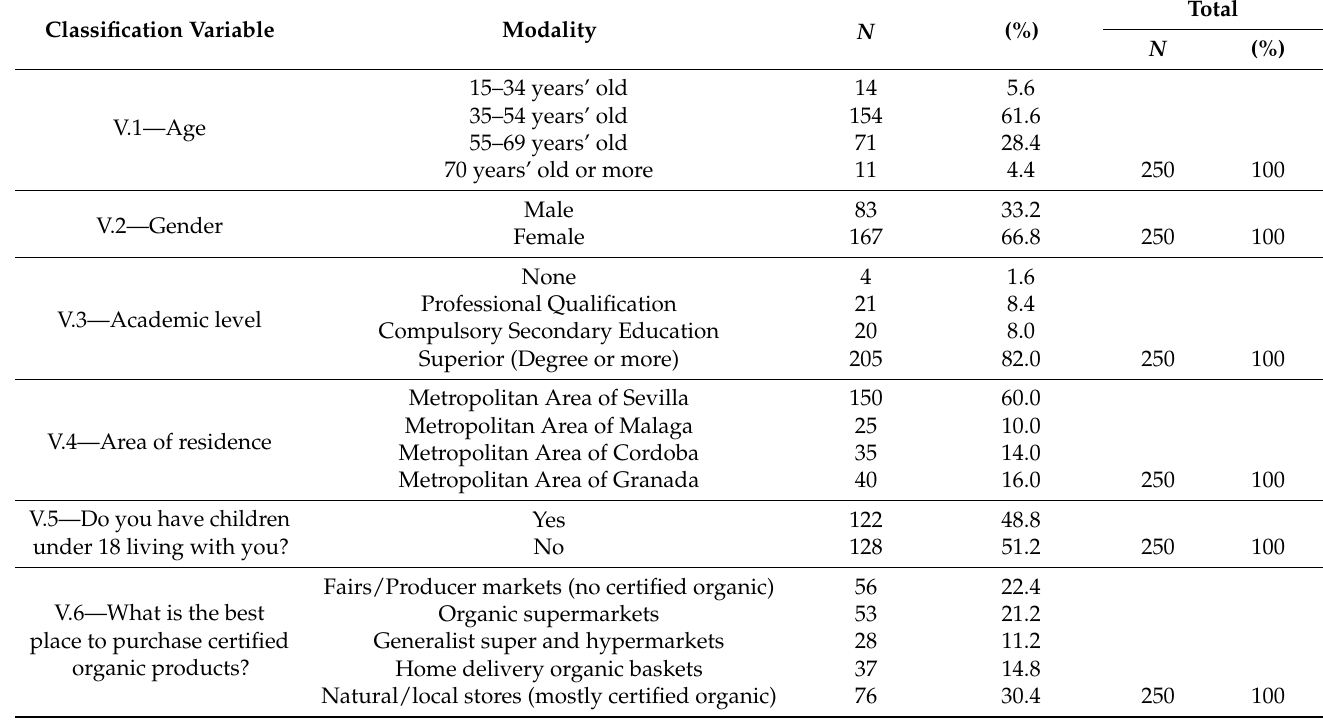
Table A2. Summary Demographics for Survey